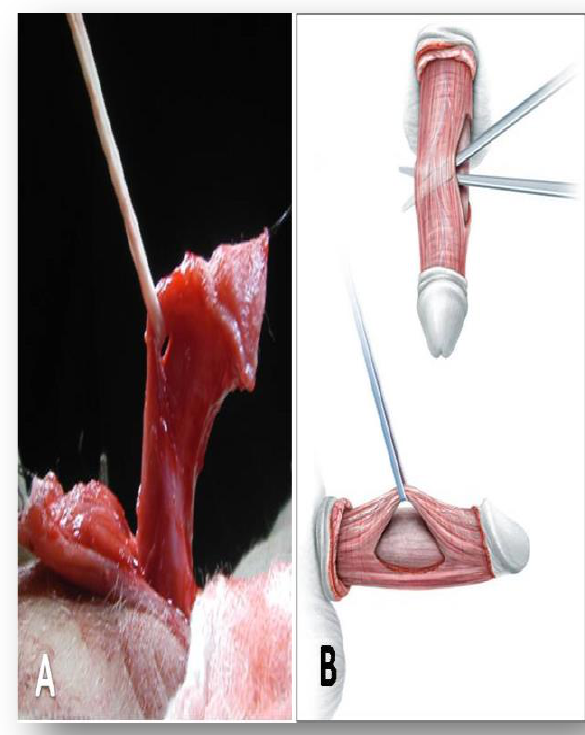
Figure 5: Neurovascular bundle mobilization and elevated with vascular tapes. (A) In medical city \Iraq, (B). (22)